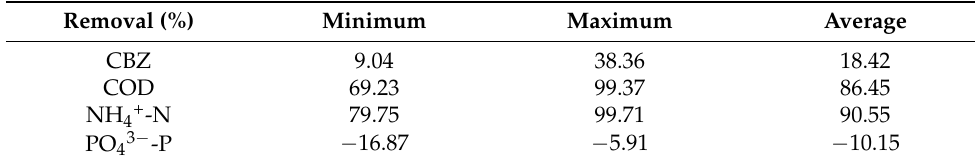
Table 2. CBZ, COD, ammonia, and phosphorus removal efficiency.